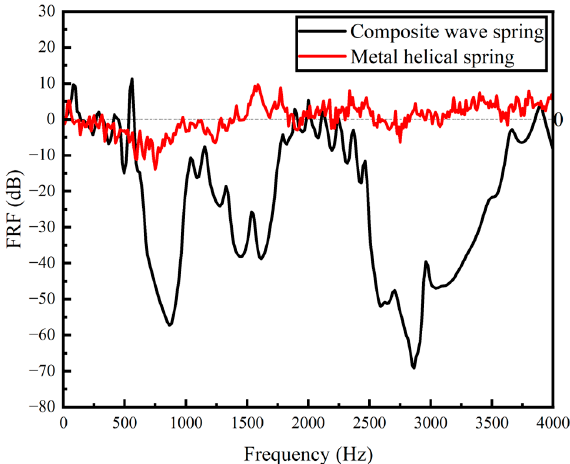
Figure 14. The results of frequency response characteristics of GFRP wave spring and metal helical spring.